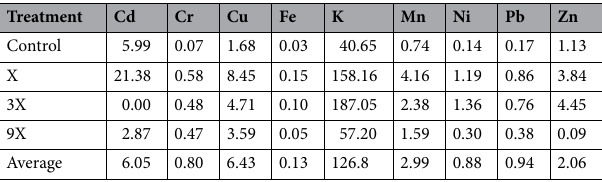
Table 8. Bioconcentration factor (BCF) in shoots.